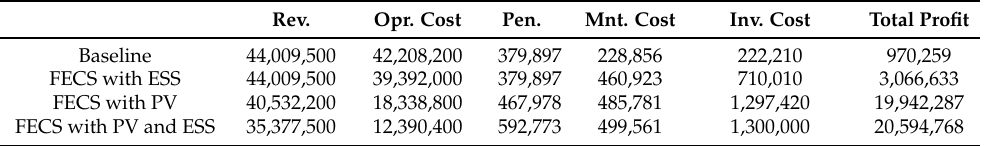
Table 4. The total cost of the FECS with the commute distribution during the planning period for the four cases, which includes the operational cost, penalties, maintenance cost, and investment cost. The total profit is revenue minus total cost. All values are in USD. Rev. Opr. Cost Pen. Mnt. Cost Inv.